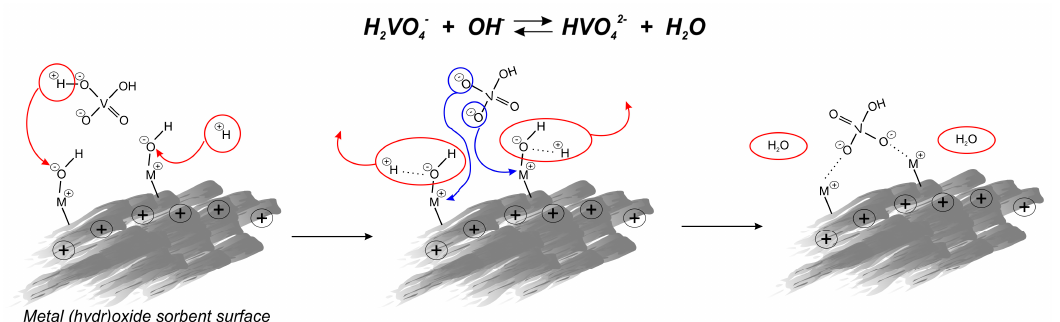
Figure 5. Vanadium adsorption isotherms obtained for 0.35 g/L dry mass of GFH and E-33, and 0.50 g/L of GTO (25 °C, ionic strength 0.01 M NaClO 4 , initial vanadium concentration 50 mg/L), taken from [68].